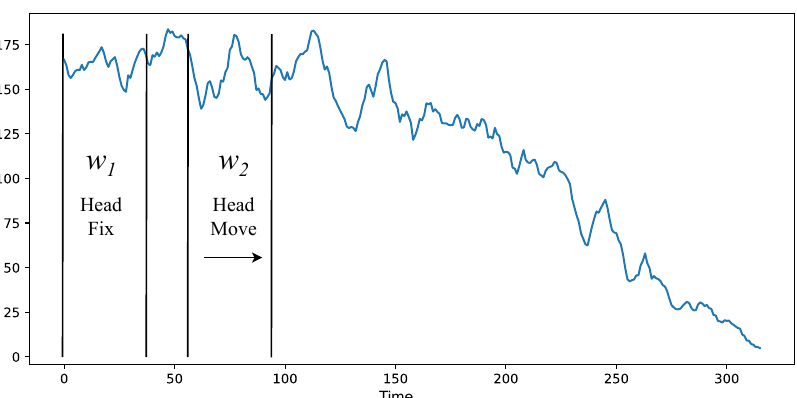
Figure 9. Explanation of HFHM strategy. We see one sliding window of observation from head is moving while the other window at the head of observation is